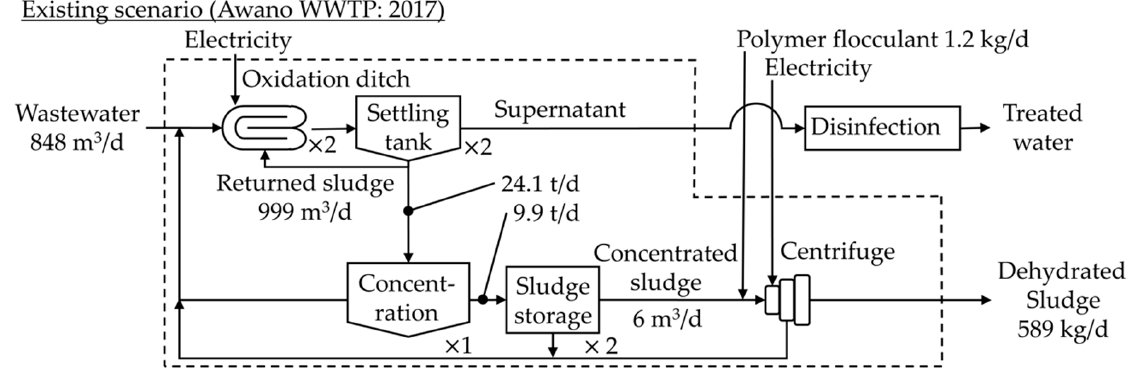
Figure 5. Current estimated system flow at Awano WWTP.